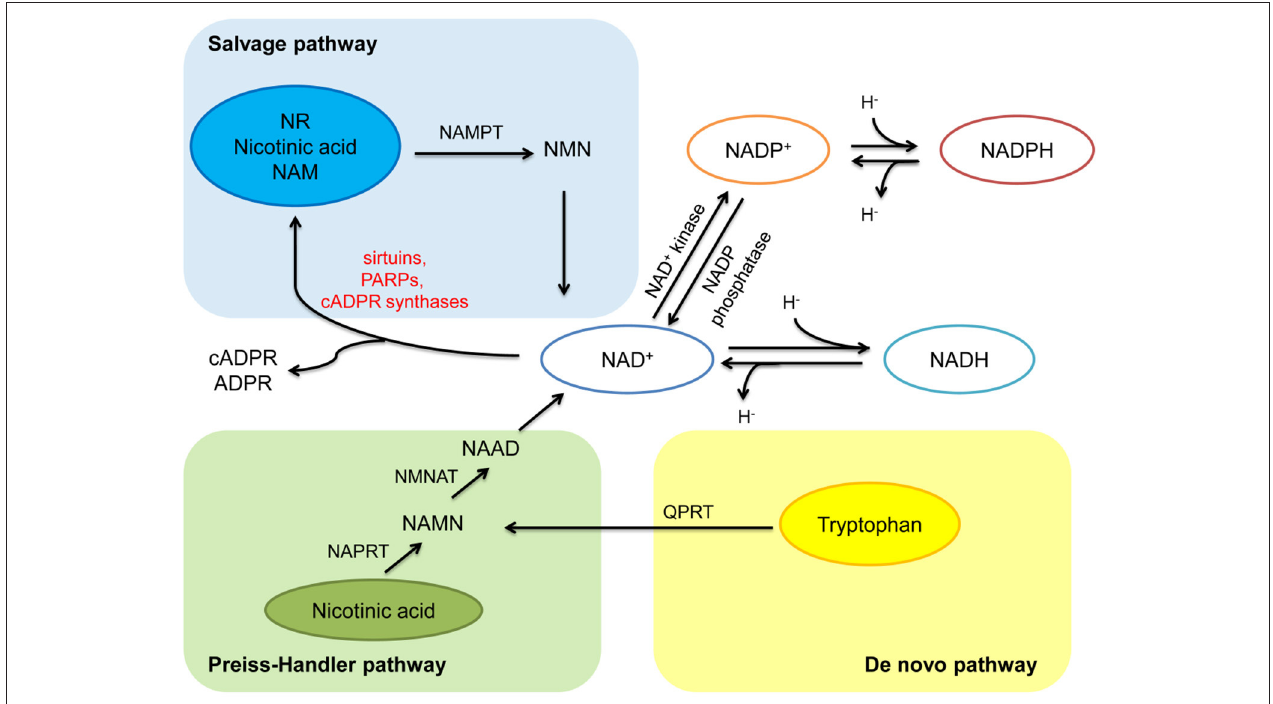
FIGURE 1 | Anabolism and catabolism of NAD + . NAD + is synthesized from four precursors including nicotinamide (NAM), tryptophan, nicotinic acid, and nicotinamide riboside (NR) through three pathways (salvage pathway, de novo pathway, and Preiss-Handler pathway). In salvage pathway, the precursors are converted into an intermediate called nicotinamide mononucleotide (NMN) through nicotinamide phosphoribosyltransferase (NAMPT). Then NMN is converted into NAD + via nicotinamide mononucleotide adenylyltransferase (NMNAT). NAD + generated by this pathway is consumed by multiple enzymes including sirtuins, PARPs, and cADPR synthases, to generate NAM, and reused in salvage pathway. In Preiss-Handler pathway, nicotinic acid is converted into nicotinate mononucleotide (NAMN) through nicotinic acid phosphoribosyltransferase (NAPRT), then NAMN is converted into nicotinic acid adenine dinucleotide (NAAD) through NMN